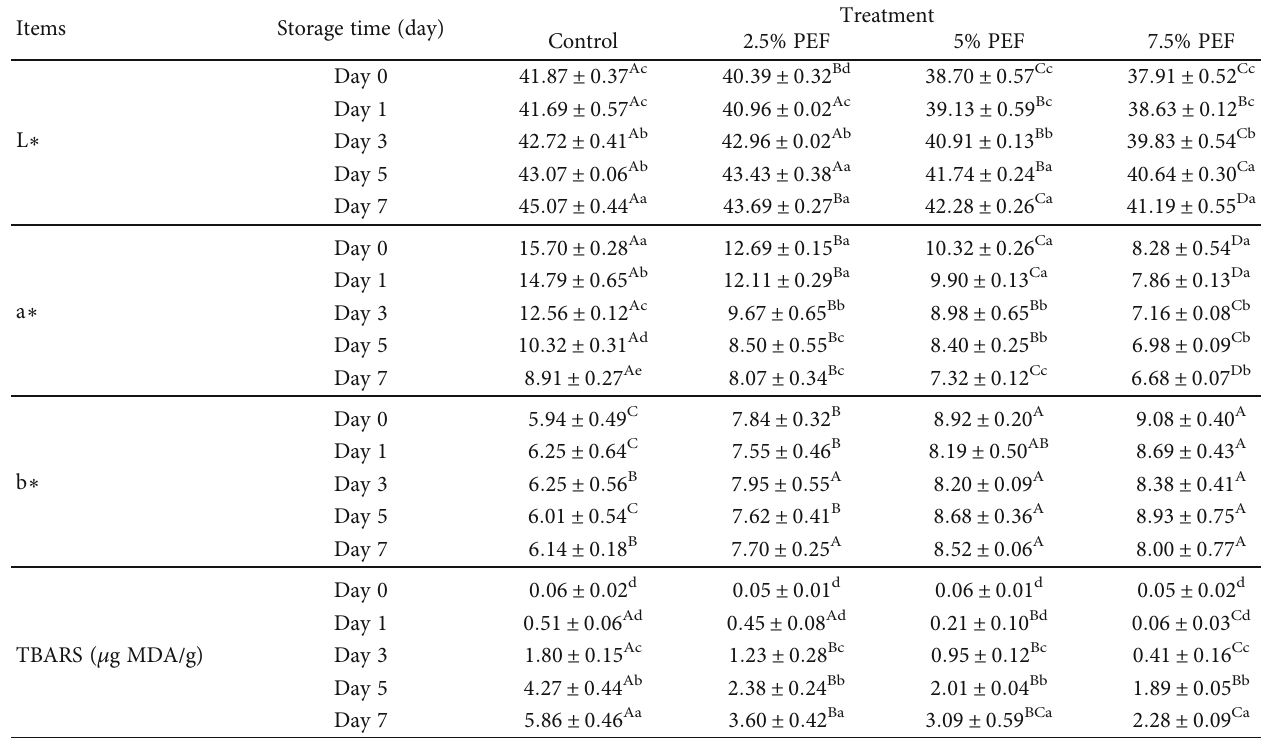
Table 5: Color stability and lipid oxidation of beef patties containing di ff erent concentrations of PEF during retail display storage. Items